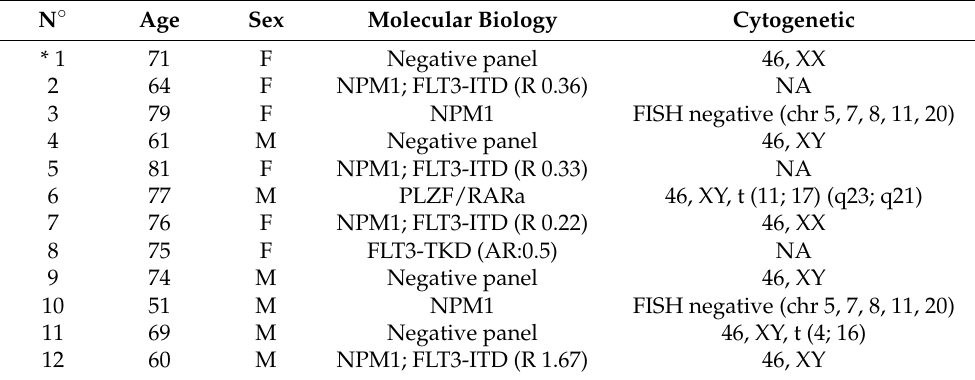
Table 1. Molecular and genetic features of primary AML